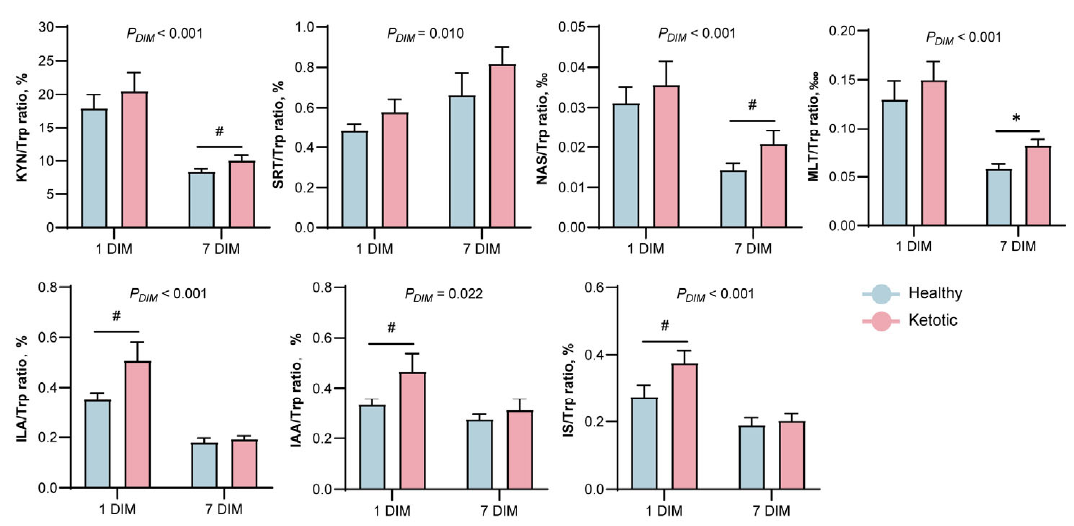
Figure 3. Ratios of individual metabolites to Trp between the healthy and ketotic dairy cows. Trp, tryptophan; KYN, kynurenine; SRT, serotonin; NAS, N ‐ acetylserotonin; MLT, melatonin; ILA, in ‐ dole ‐ 3 ‐ lactic acid; IAA, indoleacetic acid; IS, 3 ‐ indoxyl sulfate. 0.05 ≤ # p < 0.1, * p < 0.05.